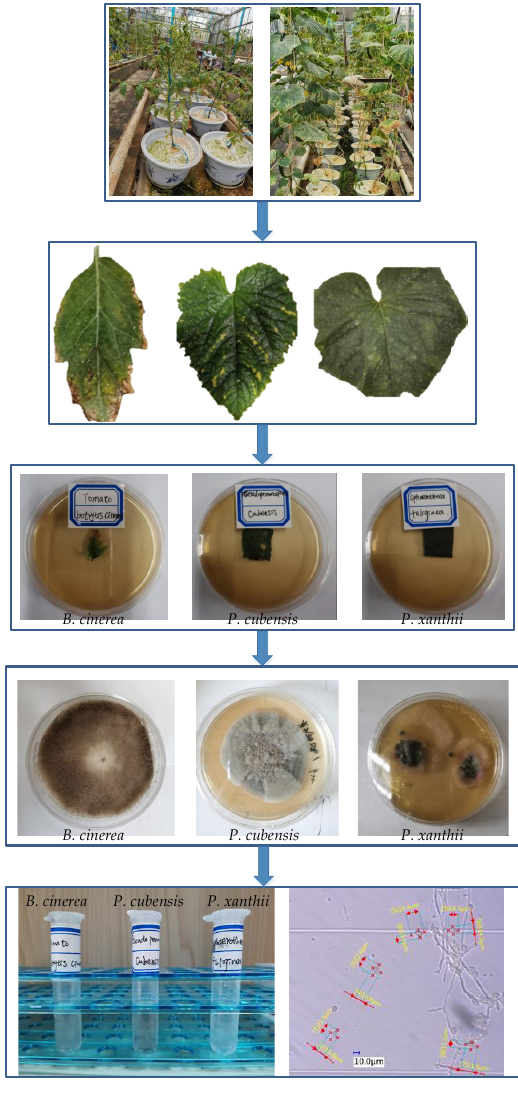
Figure 1. Extraction and identification process for the airborne disease spores.